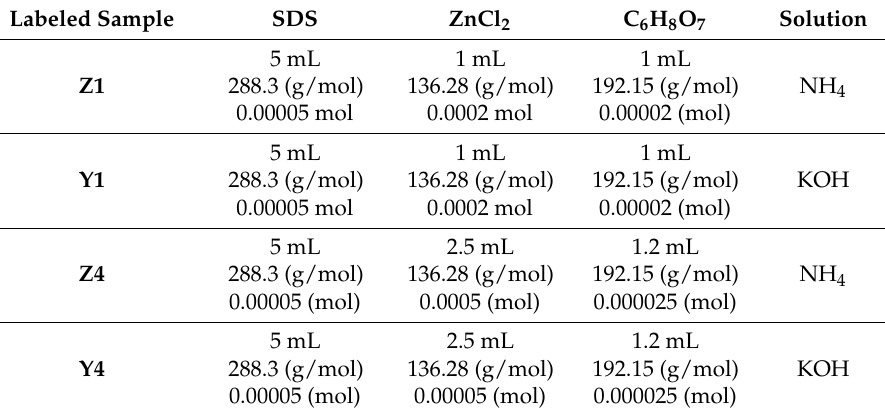
Table 1. Details of the solutions to synthetize ZnO nanoparticles.